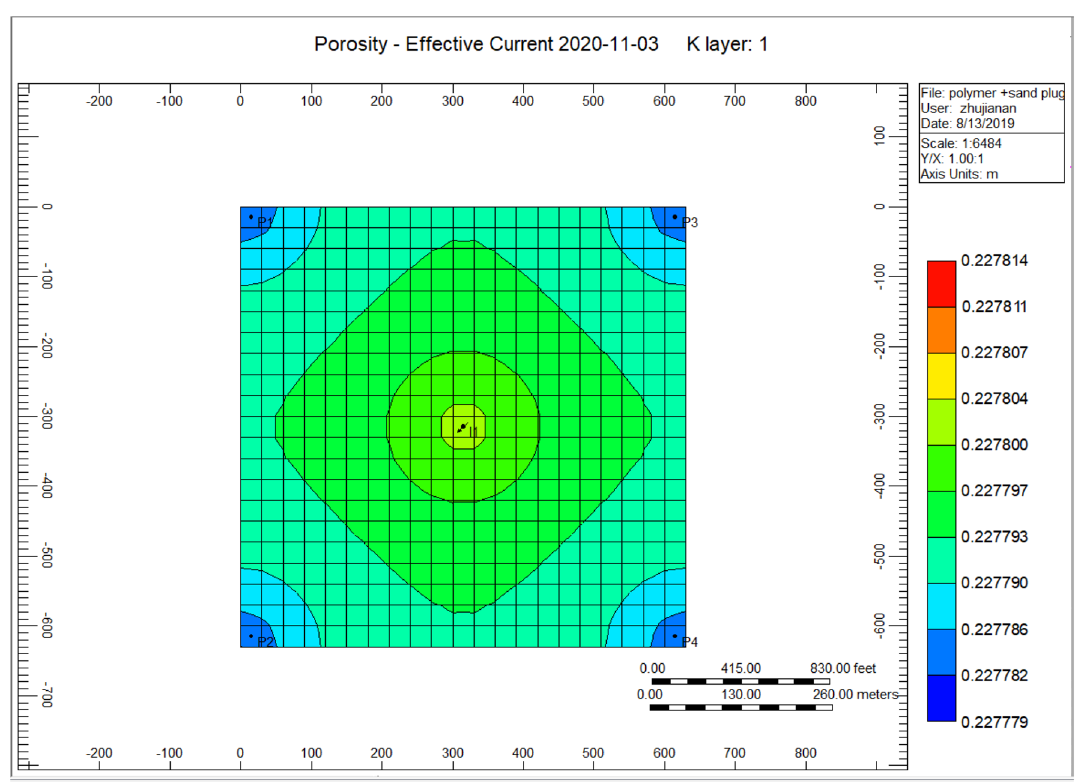
Figure 12. Indicates the porosity increase of the cross-linked gel performance model CMG STARS 2017.10 URL: https:// www. cmgl.